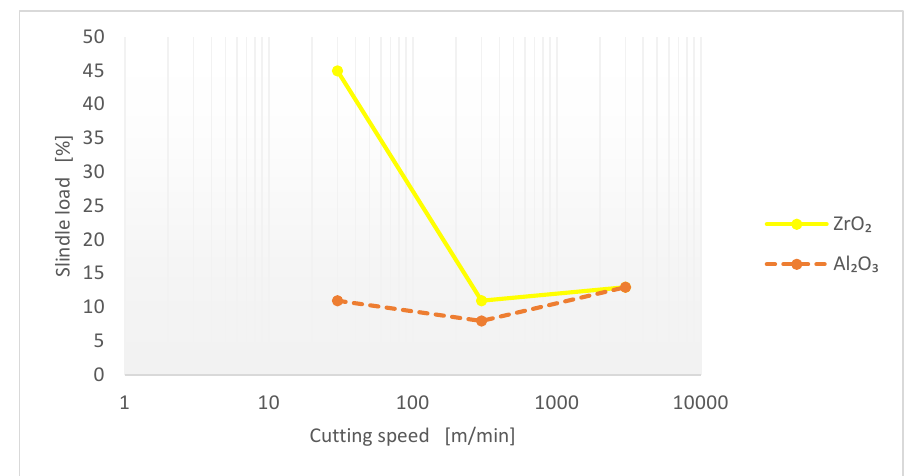
Figure 3. Influence of cutting speed on load of the spindle.